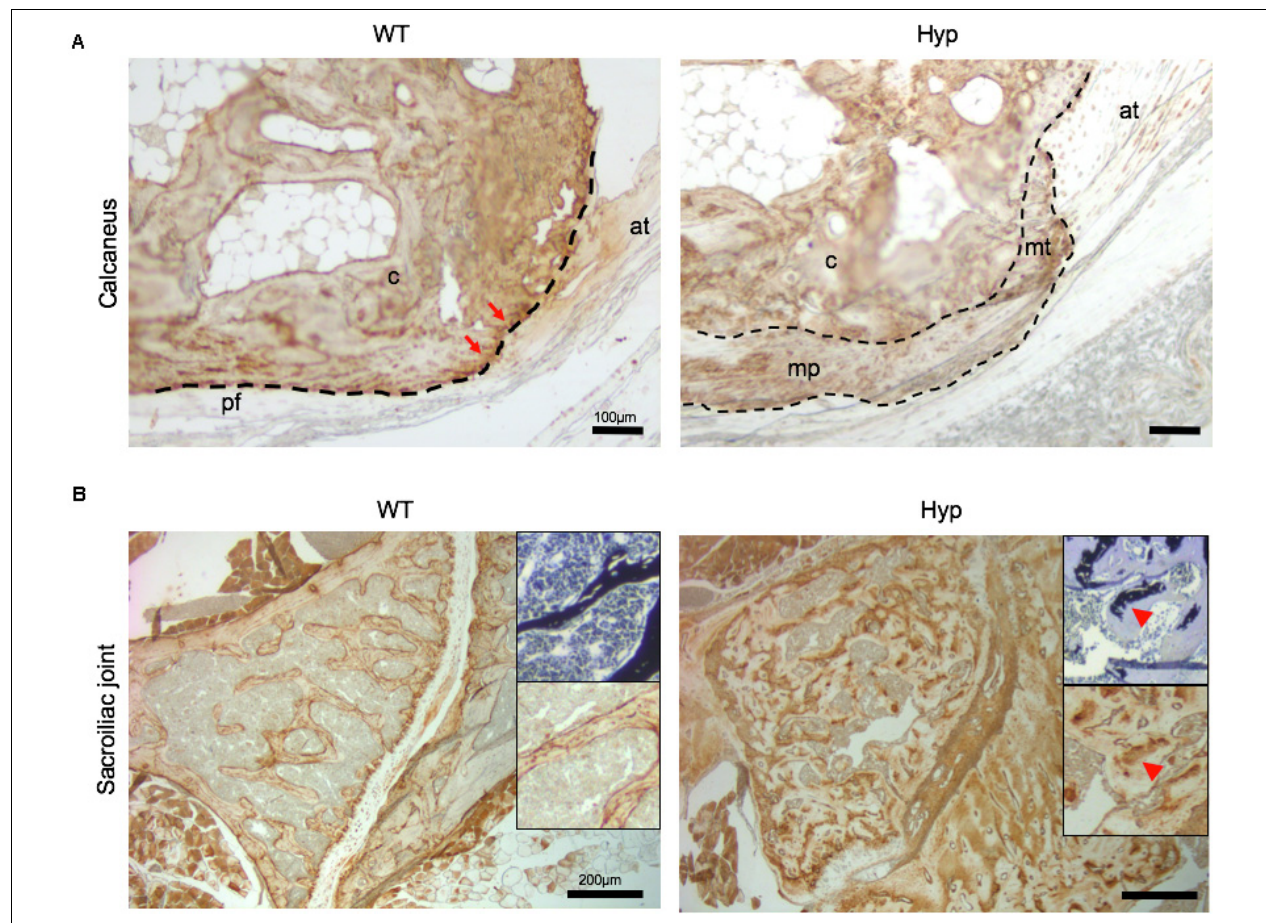
FIGURE 7 | OPN expression in osteoarticular lesions in WT and Hyp mice. (A) WT calcaneal enthesis showed a strong OPN expression at tidemark (red arrows) between uncalcified and calcified fibrocartilage compared to Hyp mice at M12. Cellular expansion of mineralizing fibrochondrocytes of both Achilles tendon and plantar fascia ligament insertions into the calcaneal tuberosity showed faint OPN expression in Hyp mice. pf, plantar fascia ligament; at, Achilles tendon; mt, mineralized fibrochondrocytes of Achilles tendon; mp, mineralized fibrochondrocytes of plantar fascia ligament; c, calcaneal tuberosity; t, tendon (scale bars, 100 µ m). (B) OPN immunostaining in Hyp mice showed a strong expression in sacroiliac joint compared to that in WT mice at M3. The staining was associated with the mineralized matrix rather than the enlarged osteoid matrix (red arrowheads) (scale bars, 200 µ